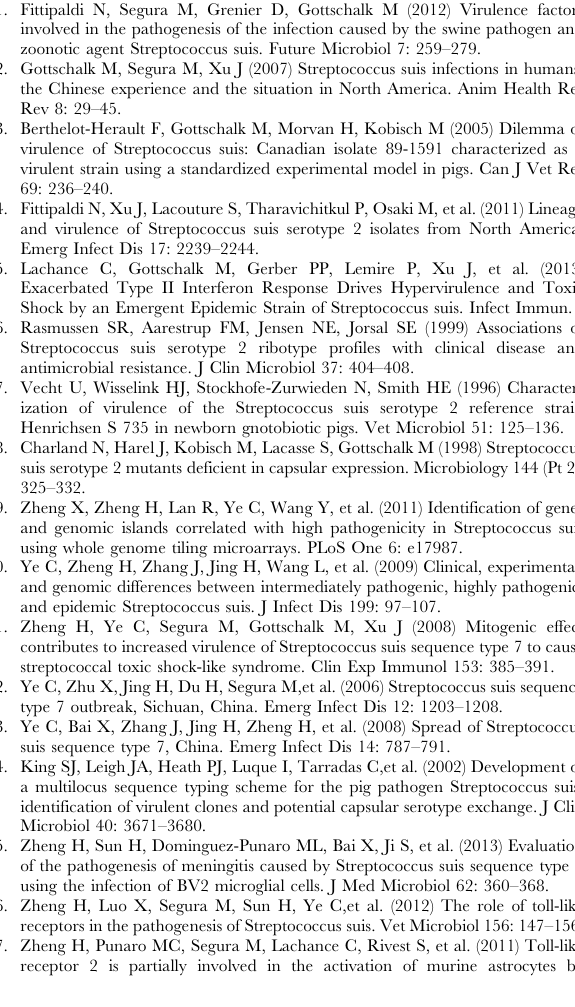
Table S2 Summary of the 17 GI